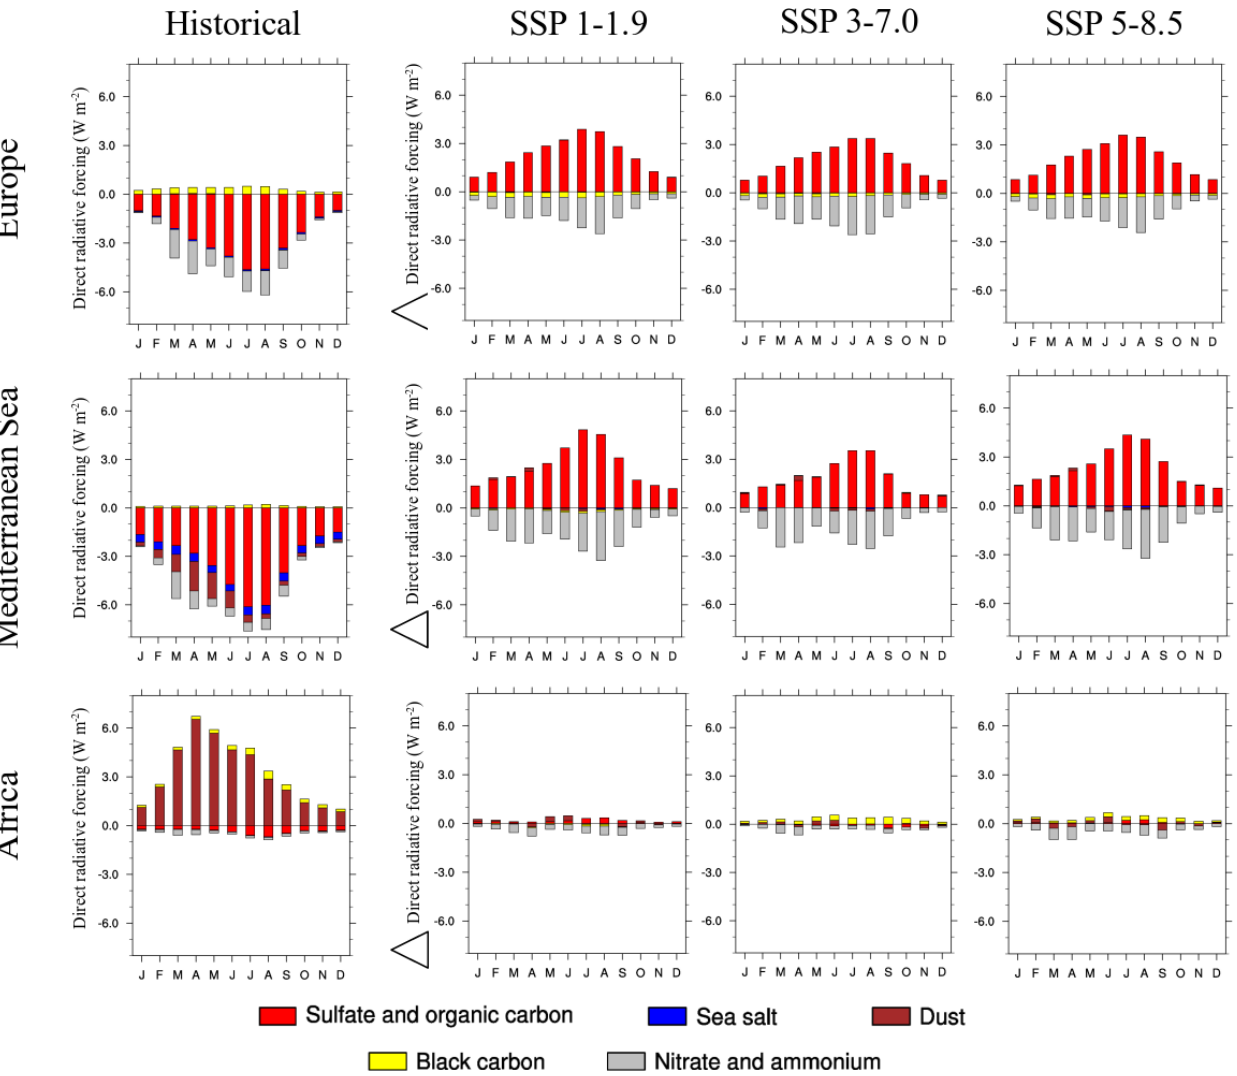
Figure A3. SW DRF evolution (Wm − 2 ) at the TOA of sulfate and organic carbon (in red), sea salt (in blue), dust (in brown), black carbon (in yellow) and nitrate and ammonium (in grey) between the historical period (1971–2000) and the future period (2021–2050) according to SSPs 1-1.9, 3-7.0 and